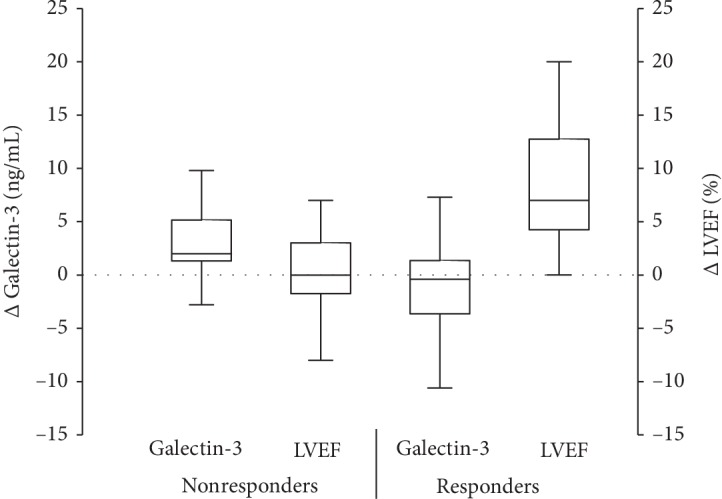
Comparison of plasma galectin-3 level changes between responders and demonstrated that galectin-3 serum levels decreased in responders but increased in nonresponders at 3-month follow-up. Furthermore, LVEF did not change significantly in nonresponders but increased significantly in responders.